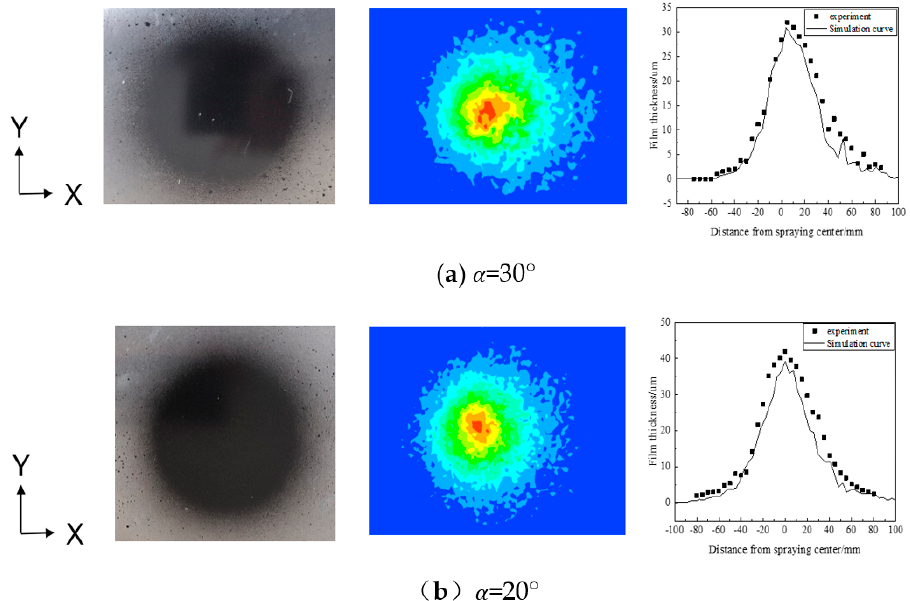
Figure 14. Comparison of coating film thickness between the spraying experiment and simulation experiment.